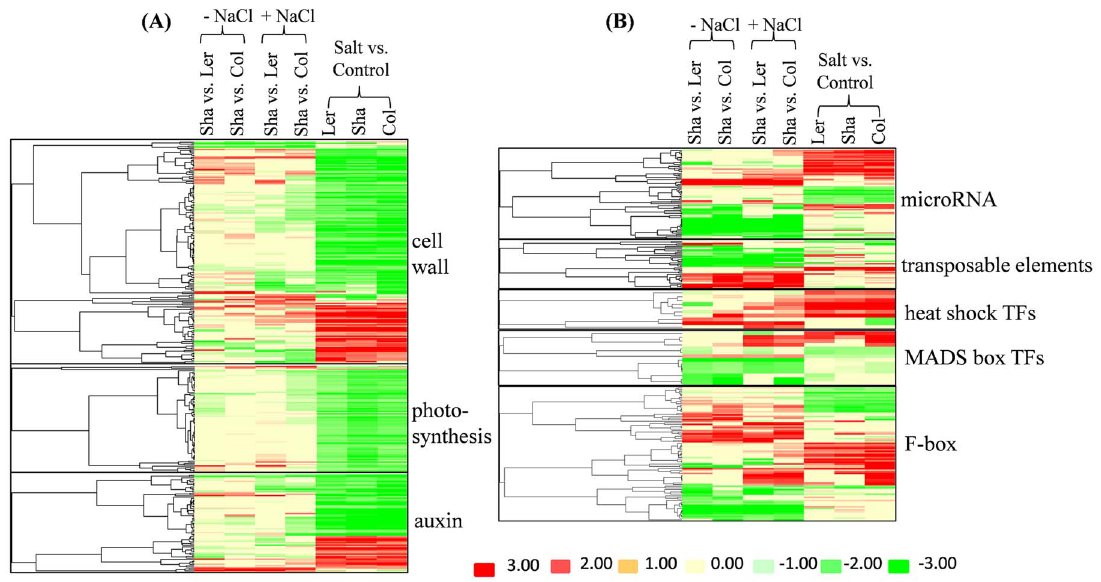
Figure 6. Cluster analyses of transcripts involved in specific pathway. Red, increase in transcript abundance (up-regulation); green, decrease in transcript abundance (down-regulation); yellow, no change. The color scales were also indicated. Hierarchical cluster analysis was applied for differentially expressed transcripts (P , 0.05 and log 2 fold change . 1 or , 2 1) with Cluster 3.0 software. The resulting tree figures were displayed using the software package, Java